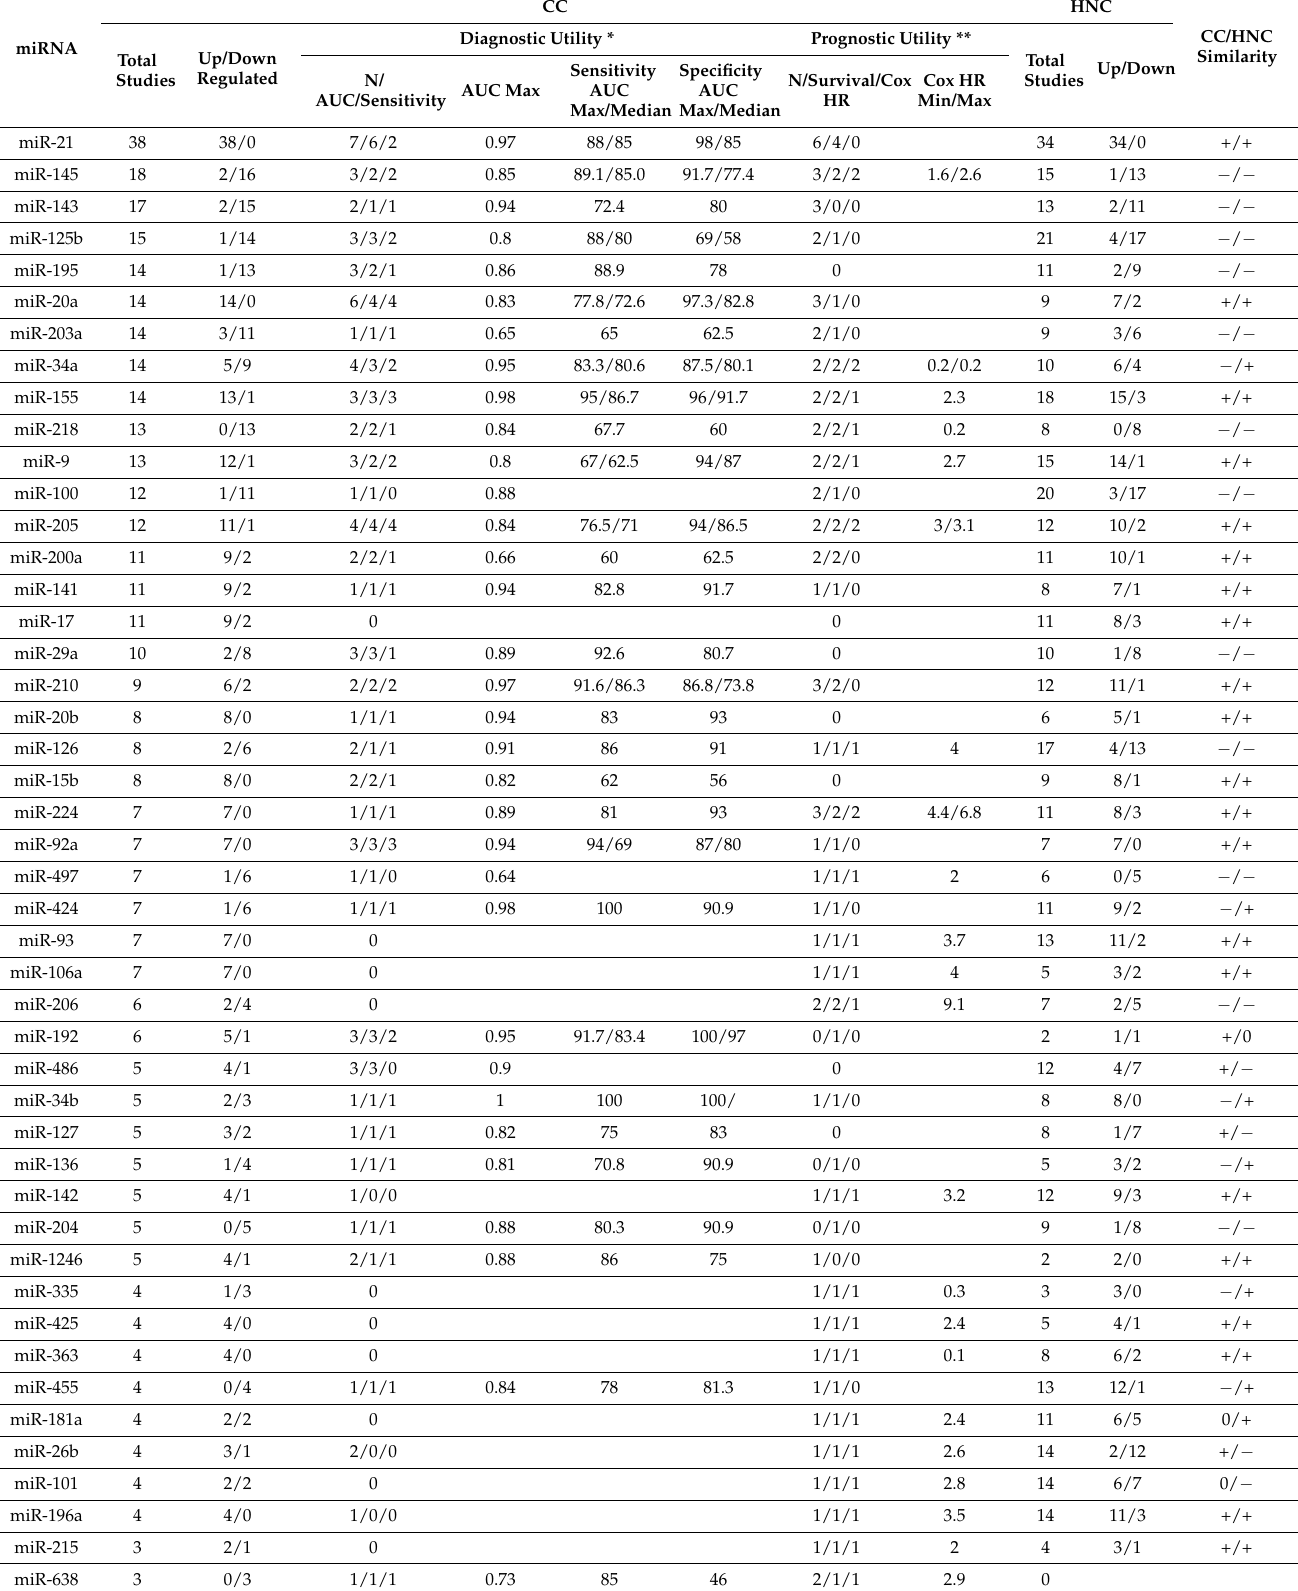
Table 3. Deregulation of miRNA and possible clinical applicability in HPV-associated cancers: summary from 187 and 59 selected publications for CC and HNC,